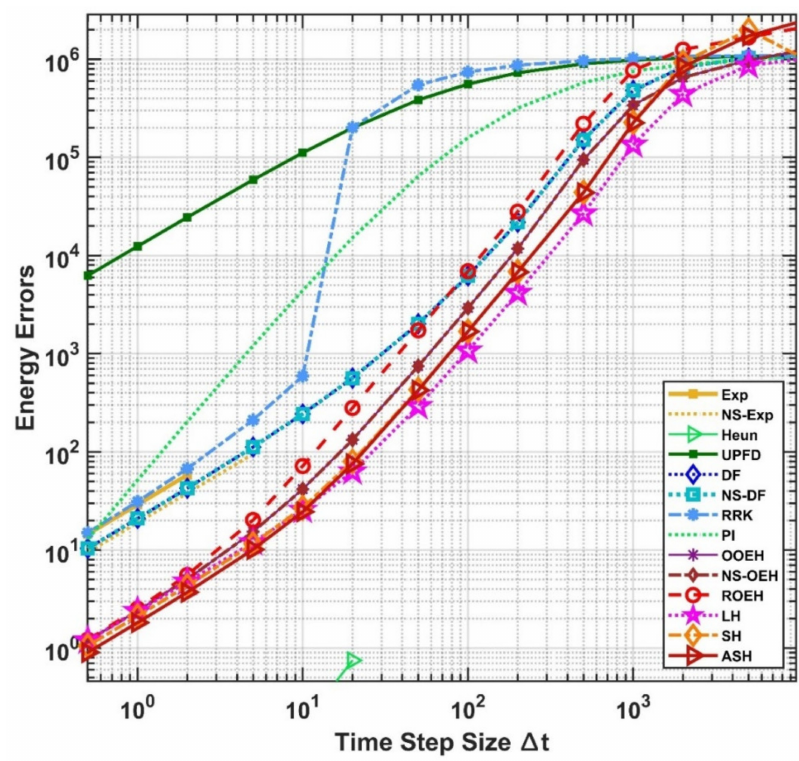
Figure 11. The energy errors as a function of the time step size ∆ t for the non-equidistant